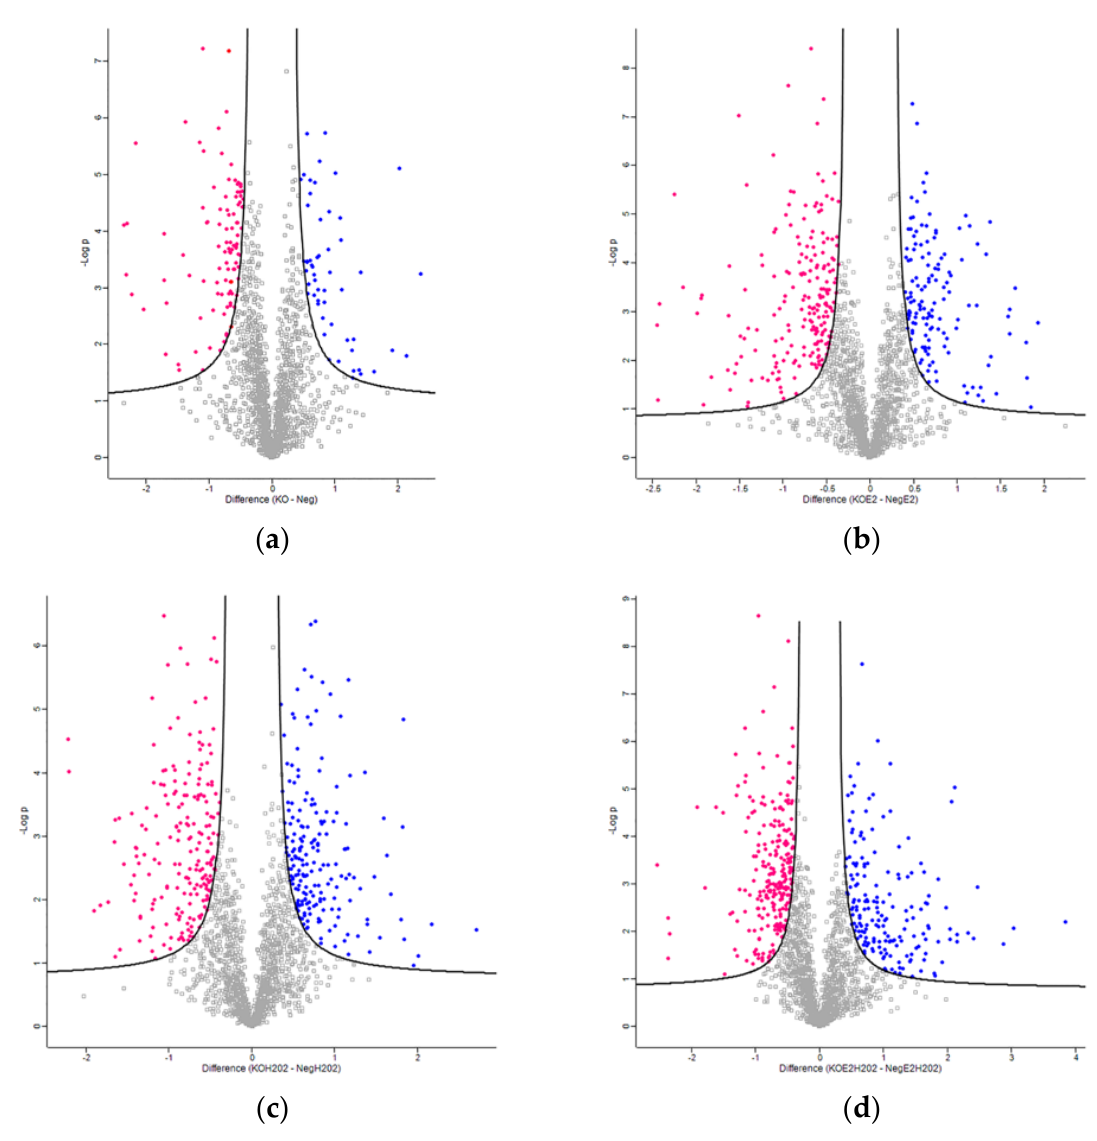
Figure 2. Global proteome distribution of the four experimental conditions. Volcano plots report the protein fold-change (indicated as Difference) against the statistical significance (–log p ) in ( a ) NGB-KO vs. Neg, ( b ) NGB-KO + E2 vs. Neg + E2, ( c ) NGB-KO + H 2 O 2 vs. Neg + H 2 O 2 , and ( d ) NGB-KO + E2 + H 2 O 2 vs. Neg + E2 + H 2 O 2 . The blue and pink dots represent the up- and downregulated proteins, respectively.